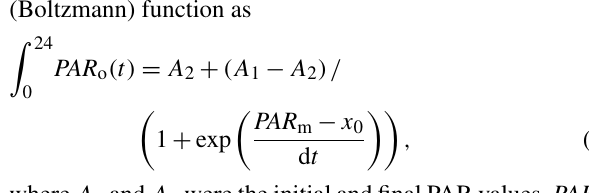
(Boltzmann) function